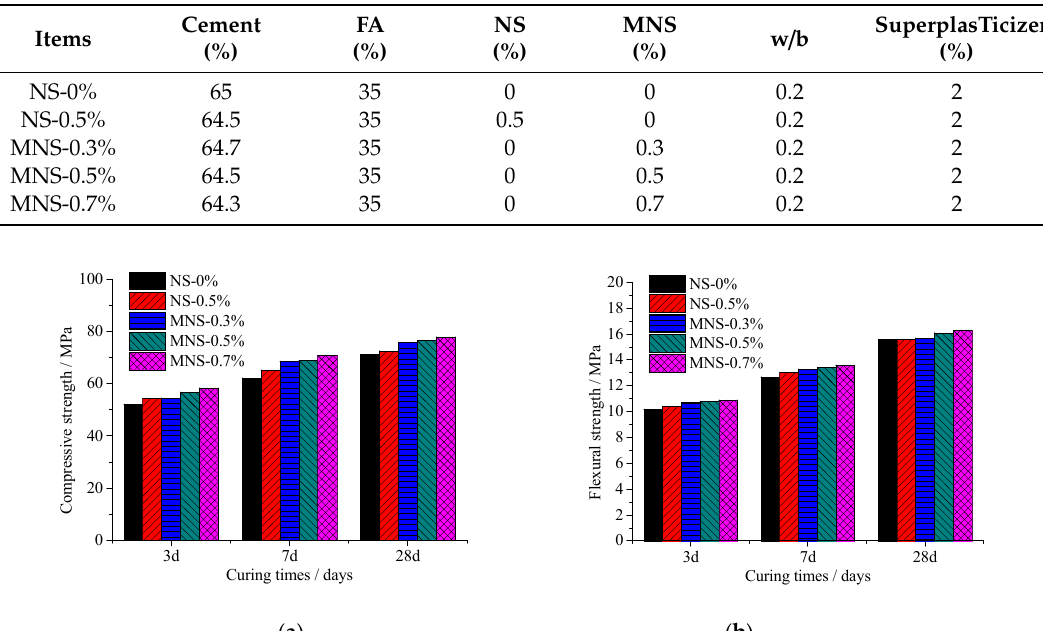
Figure 4. Compressive and flexural strengths of HPC at different curing ages. ( a ) Compressive strengths of HPC; ( b ) Flexural strengths of HPC